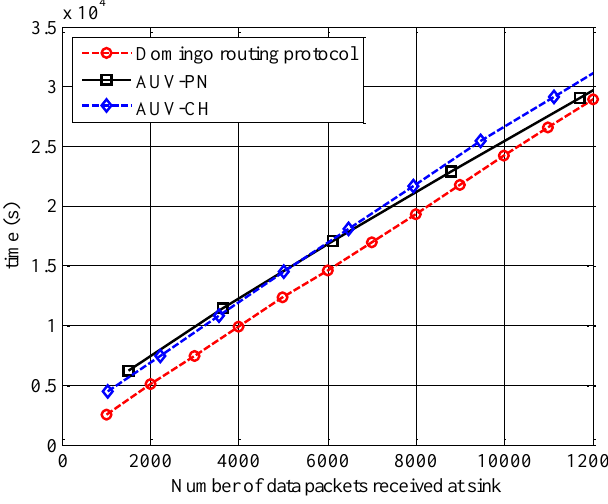
Figure 11. Data gathering latency versus number of data packets received at the sink.